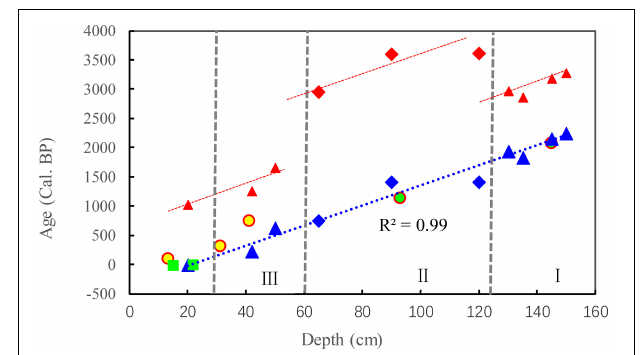
FIGURE 3 | Radiocarbon ages of sediment samples in core BL13-1-4 from Lake Bosten (the red points denote the original 14 C ages, blue points denote the 14 C ages after old carbon correction). Blue triangles denote 14 C ages of wet intervals (interval I and III; see text for details) after a correction of 1033 years. Blue diamonds denote 14 C ages of dry interval (interval II) after a correction of 2200 years. The green squares denote the 137 Cs time markers (1964-year and 1952-year). Green and yellow filled circles denote 14 C ages of plant debris and those of bulk organic matter and humic materials, respectively (data from others’ previous work; Table 3